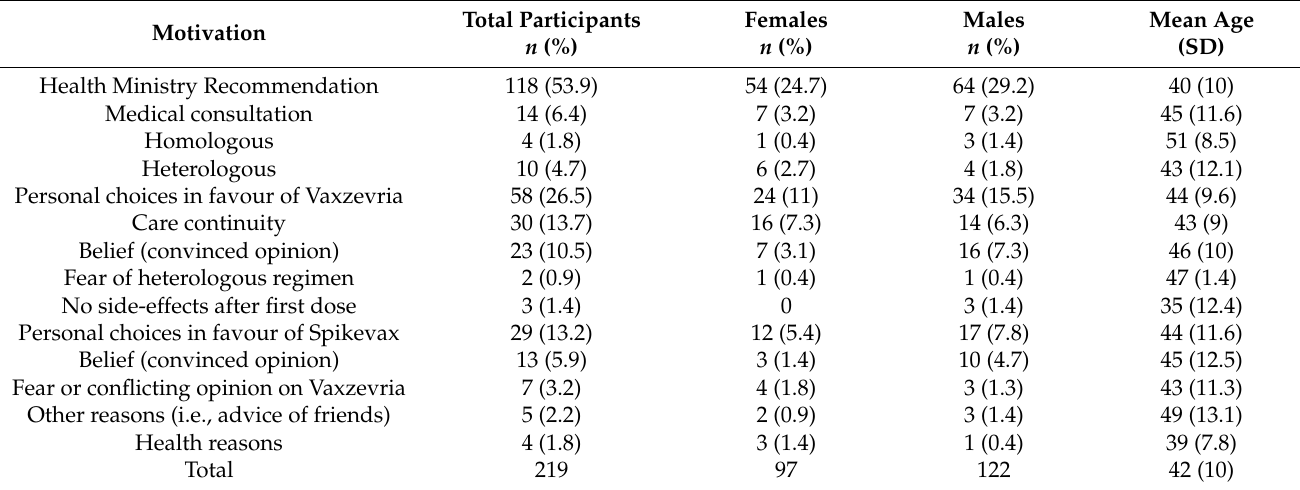
Table 4. Participants’ motivation according to the chosen vaccination